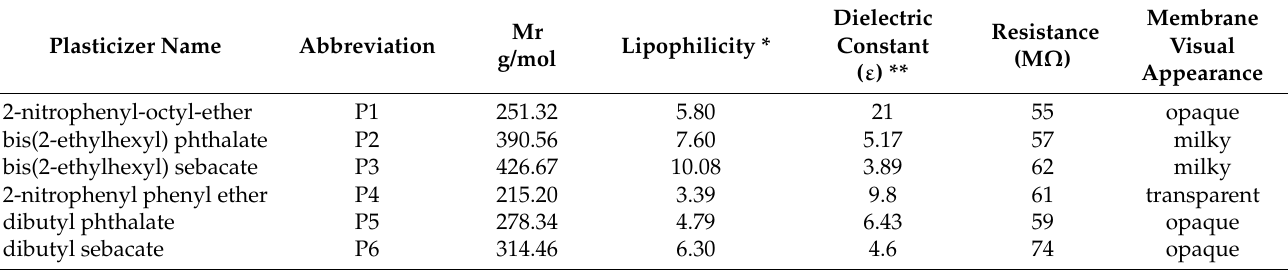
Table 1. Plasticizers and sensor membranes